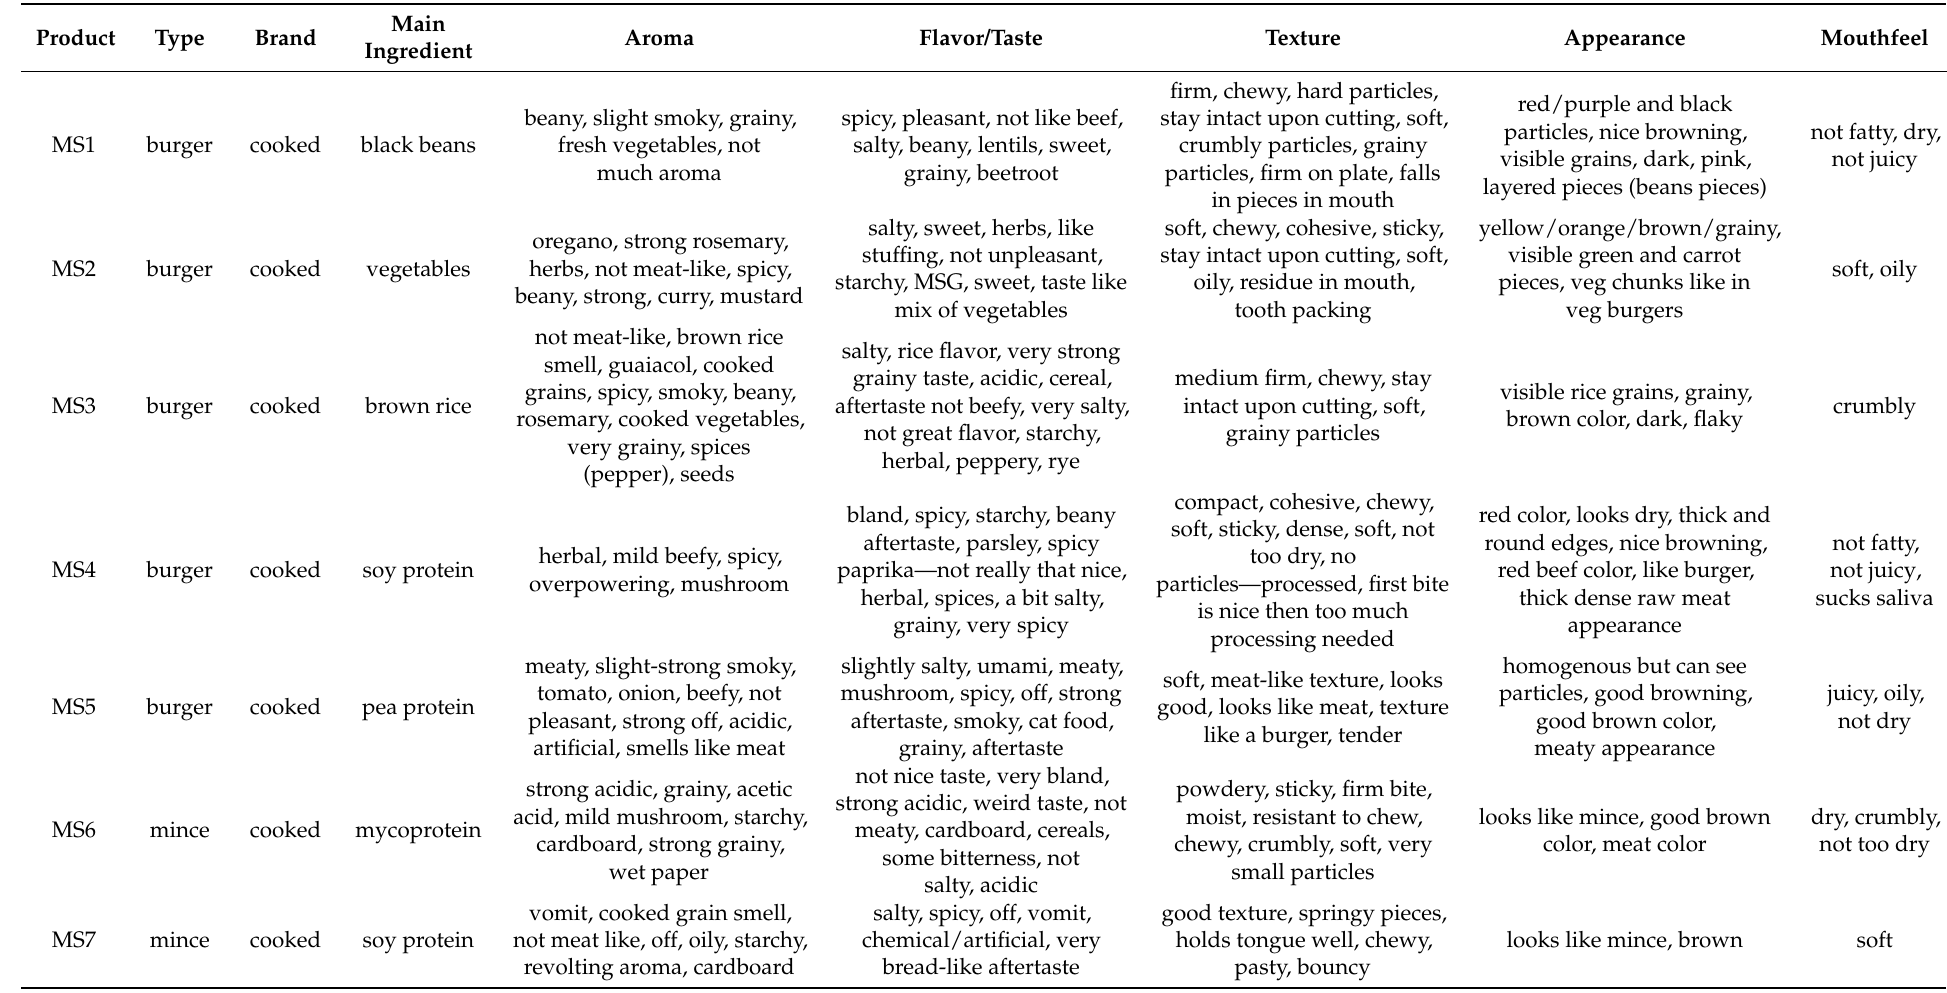
Table 2. Sensory descriptors of meat substitutes and traditional plant-based high-protein food products (n =